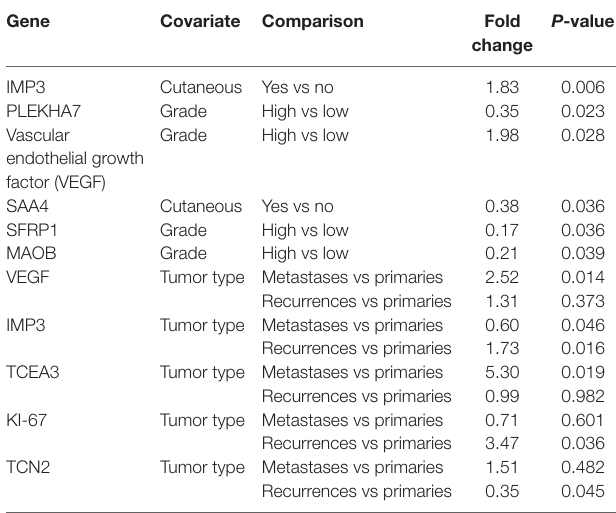
TaBle 3 | Significant associations between patient characteristics and gene